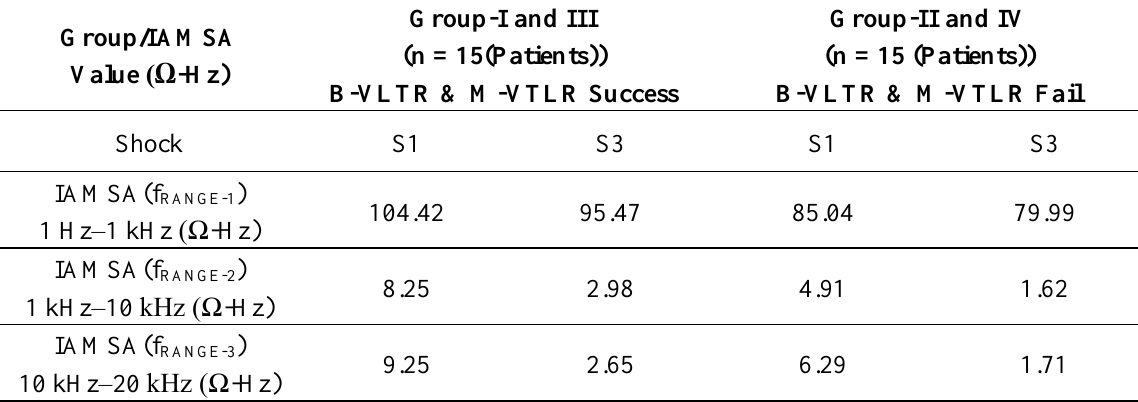
Table 4. ICI spectro-temporal variations of IAMSA for frequency bands and outcome groups .